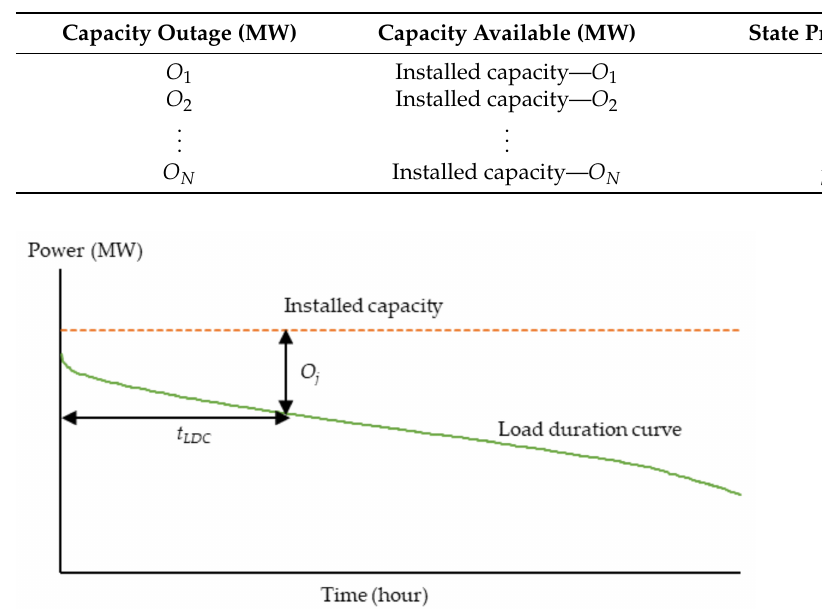
Figure 2. Example of Load duration curve with t LDC ( O j )